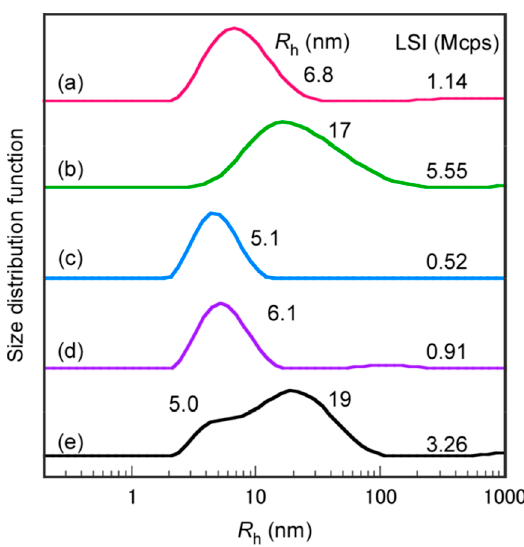
Figure 9. Hydrodynamic radius ( R h ) distributions and light scattering intensity (LSI) for ( a ) P(MPC/DMA 10 ), ( b ) P(MPC/DMA 38 ), ( c ) BSA, ( d ) mixture of P(MPC/DMA 10 ) and BSA, and ( e ) mixture of P(MPC/DMA 38 ) and BSA in phosphate buffered saline (PBS) at 25 °C. The concentrations of random copolymers and BSA were fixed at 5.0 g/L.